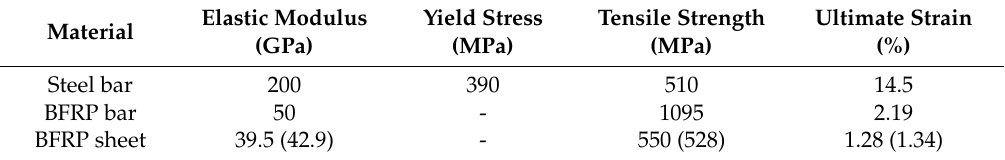
Table 1. Mechanical properties of materials.